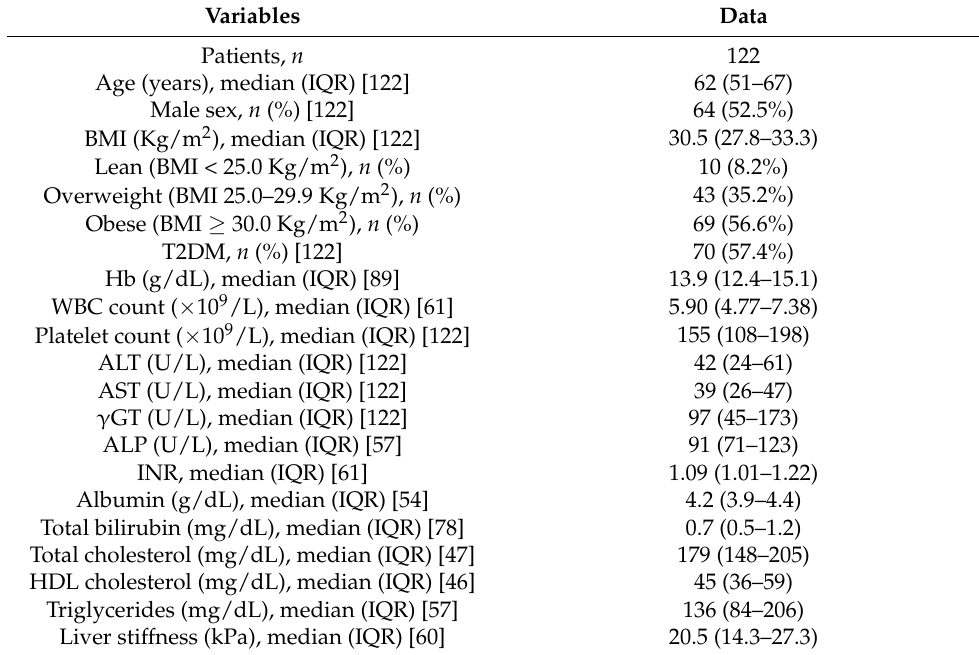
Table 1. Baseline characteristics of the study